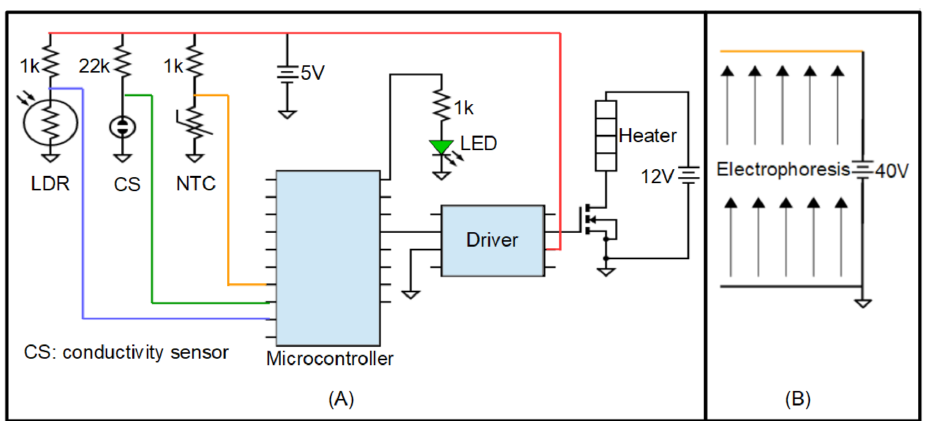
Figure 4. ( A ) Basic signal conditioning electronic circuit connected to the microcontroller. ( B ) The electrophoresis schematic circuit. The arrows indicate the direction of the